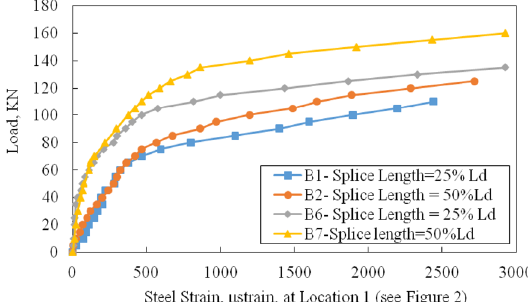
Fig. 17 Load–longitudinal steel strain of Beams B1, B2, B6 and